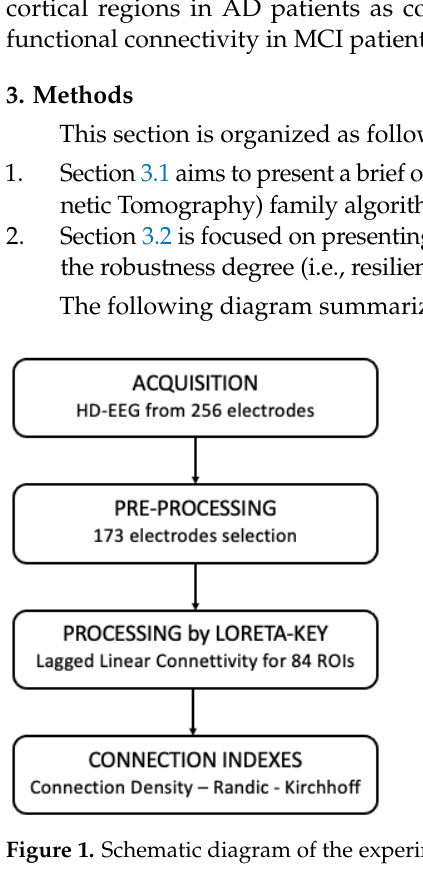
Figure 1. Schematic diagram of the experimental